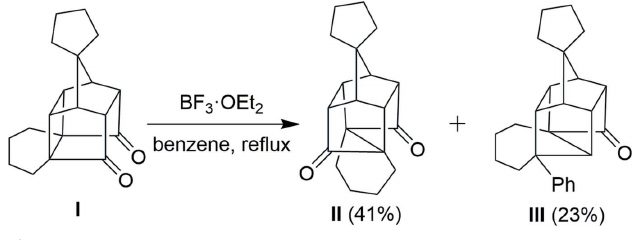
Figure 2 Lewis acid-promoted rearrangement of the cage dione I